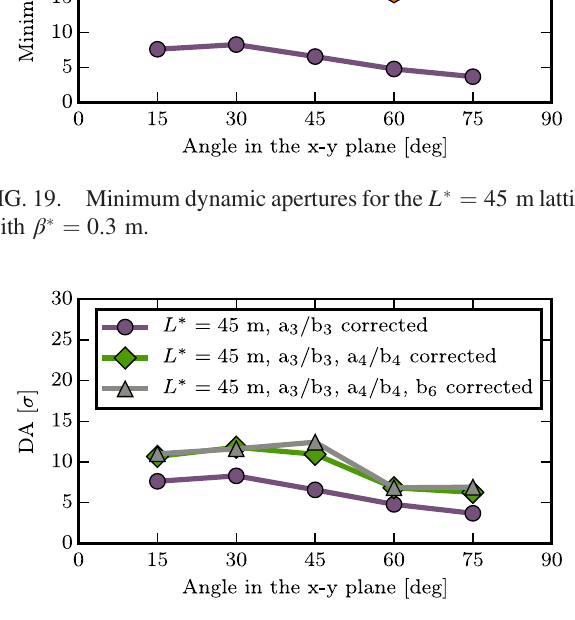
FIG. 20. Minimum dynamic apertures for the L (cid:2) ¼ 45 m lattice with β (cid:2) ¼ 0 . 3 m for different local multipolar